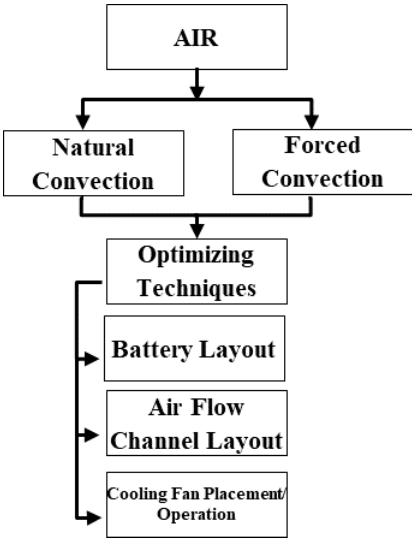
Figure 1. Classification of air-cooled battery thermal management systems (BTMS) and optimization parameters adapted from [1,4,8] .